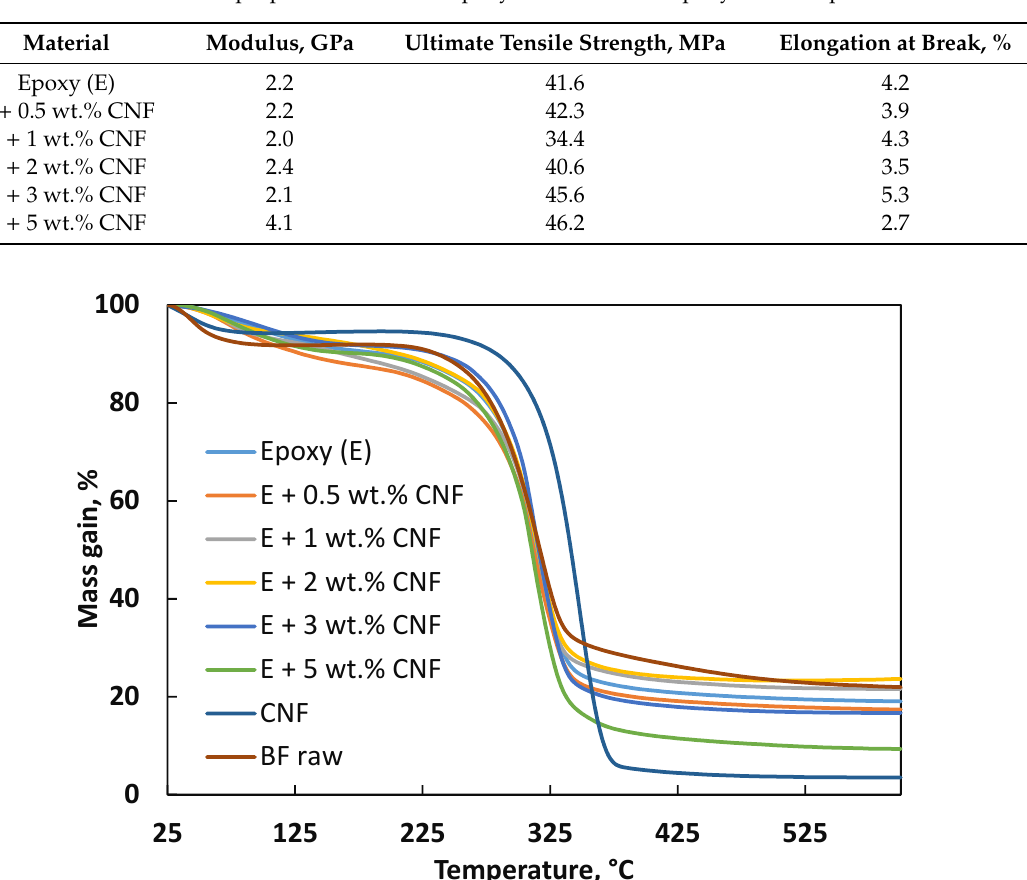
Figure 5. Tensile stress–strain curves of unfilled and CNF-filled epoxy nanocomposite series. Table 1. Tensile properties of unfilled epoxy and CNF-filled epoxy nanocomposites.